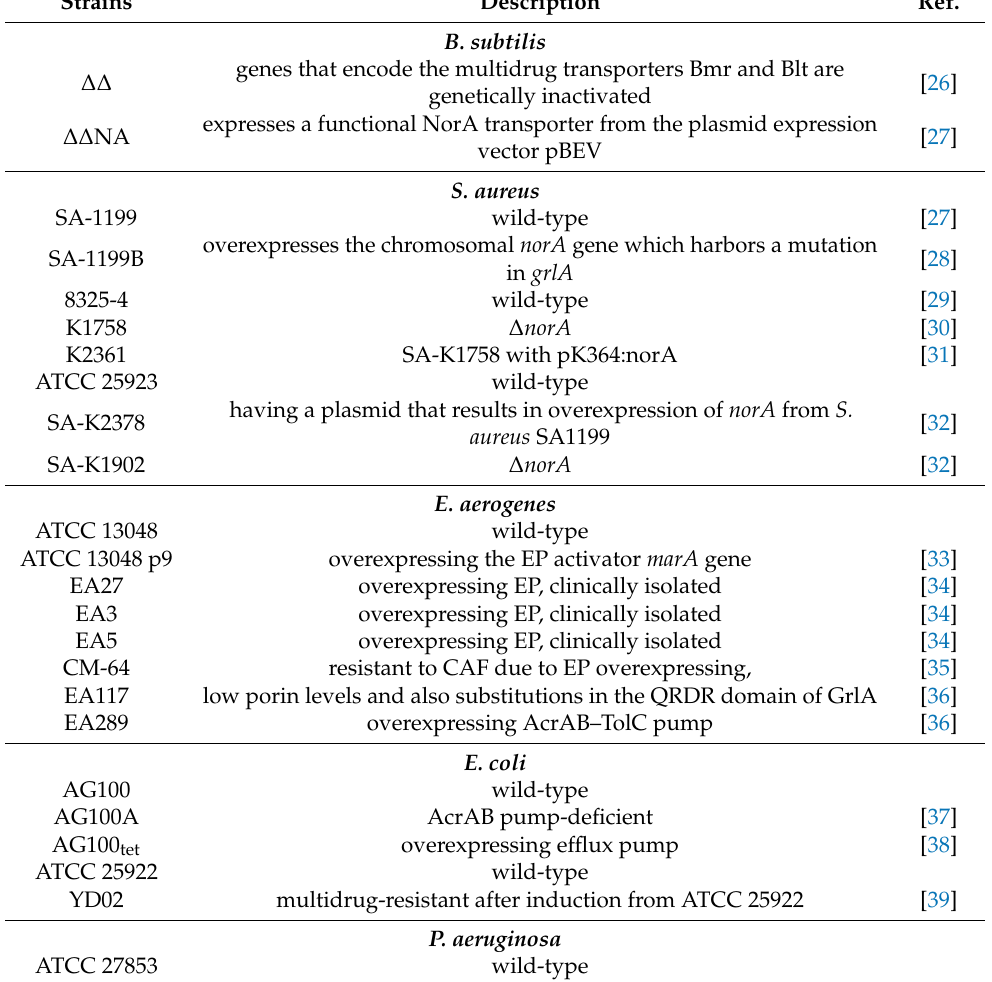
Table 1. Description of the cited strains.